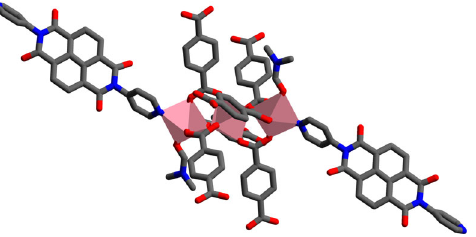
Fig. 5 Spectroscopic unity of MOF-CoNDI-py-2. It is composed of three metal ions, six TpA anions, two NDI-py and two DMF molecules. Hydrogen atoms are not shown for clarity